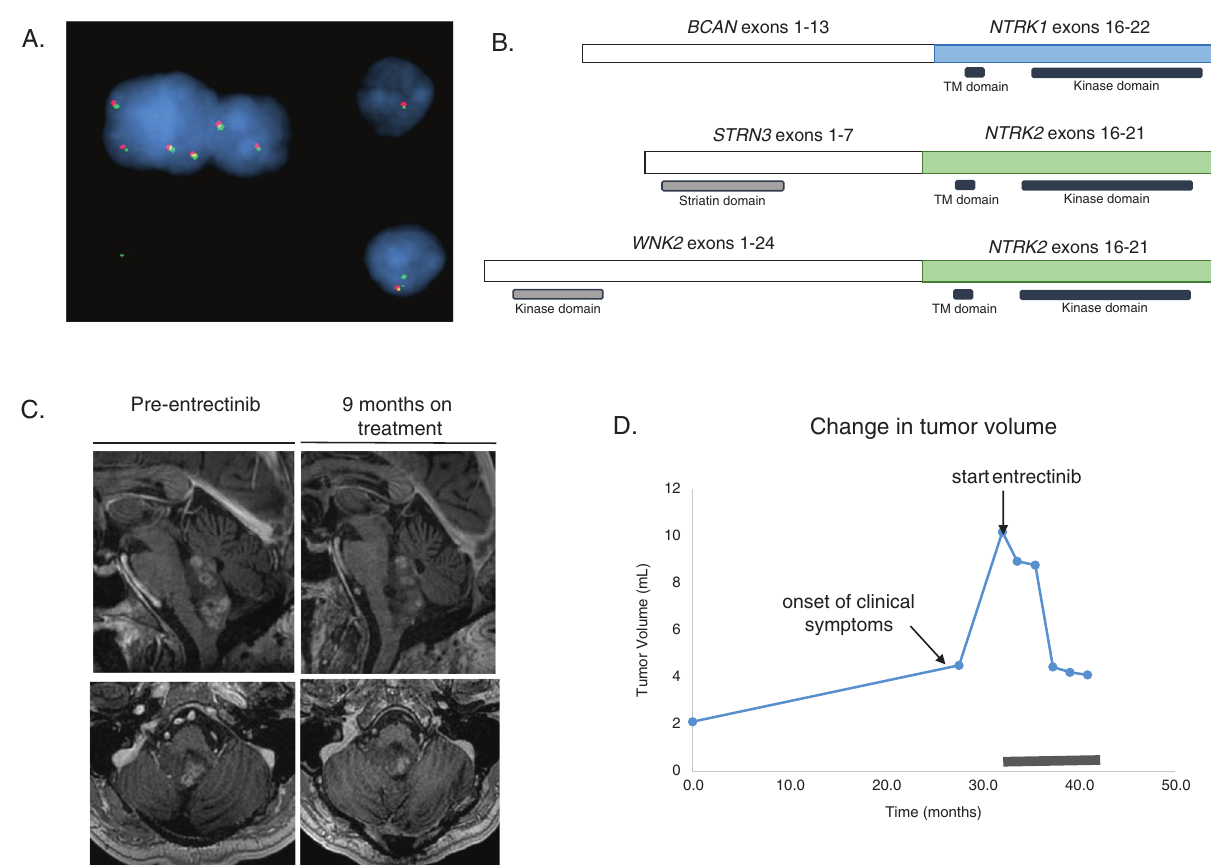
Fig. 1 NTRK fusion in glioneuronal tumors can be treated with Trk-inhibitors. a Fluorescence in situ hybridization (FISH) using split apart probes, with separation of the 5 ′ ( green ) and 3 ′ ( red ) NTRK1 signals, reveal abnormal rearrangement, with some red – green pairs showing a small green probe signal ( arrows ). b Schematic of three different NTRK- containing gene fusions discovered in the glioneuronal cohorts from MGH and Vancouver, involving either NTRK1 or NTRK2. Predicted active domains in the expression product are depicted below. TM transmembrane. c Sagittal ( top ) and axial ( bottom ) post-contrast T1-weighted MRI images of patient with BCAN-NTRK1 fusion just prior to treatment with entrectinib ( left ) and following 9 months on treatment ( right ). The T1-avid tumor visualized in dorsal pons and medulla has decreased in size during this time period. d Plot demonstrating tumor volume over time while patient was on treatment with entrectinib using MRI-derived volumetrics (see Methods). Baseline tumor volume was measured approximately 2 years prior to treatment. Tumor volume initially slowly increased, then expanded more rapidly coincident with onset of clinical symptoms. Treatment with entrectinib led to rapid and substantial decrease in tumor volume. Period on treatment denoted with thick black